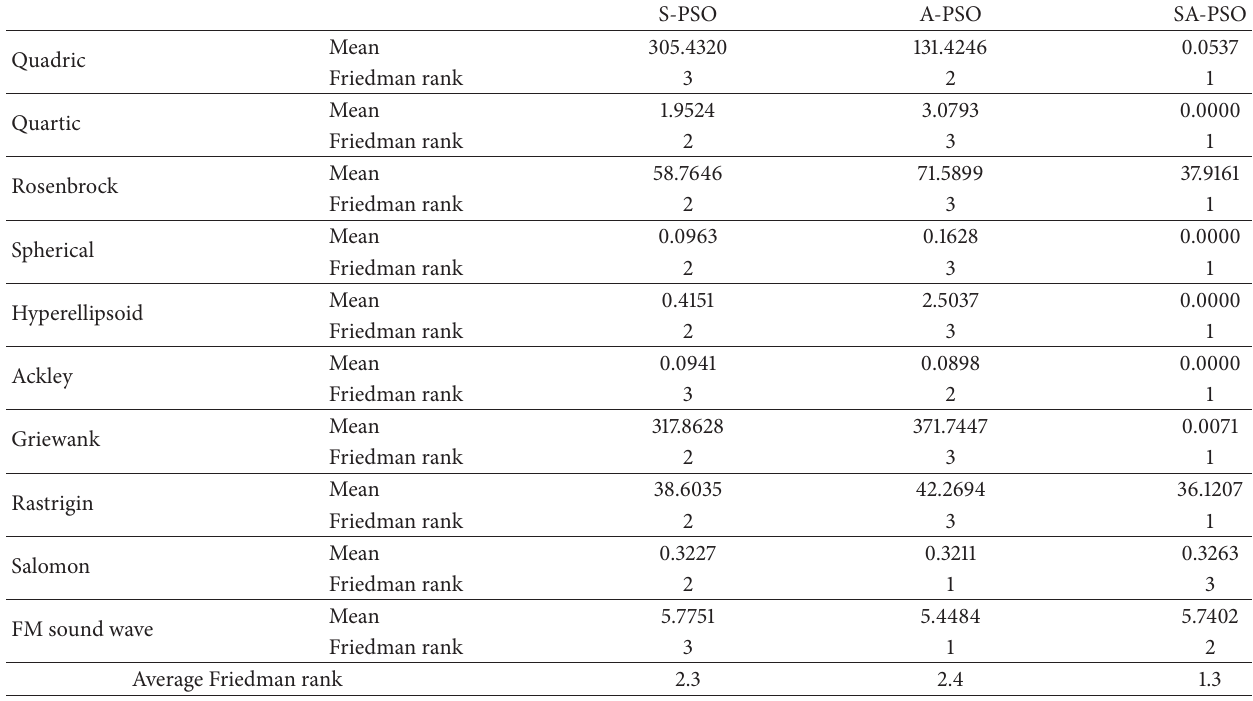
Table 4: Friedman test on the results of the experiments.